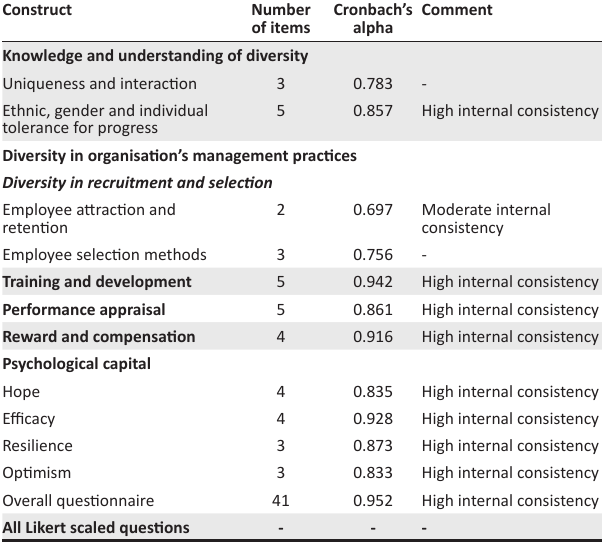
TABLE 1: Scale reliability